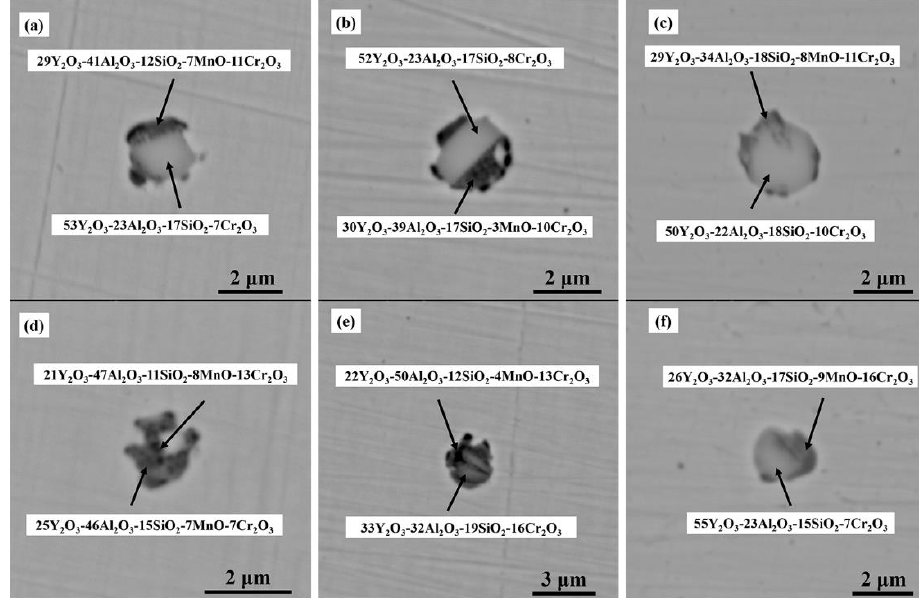
Figure 5. Morphology of typical oxide inclusions in steel #2 after isothermal heating for 0.5 h ( a ) and ( d ), 1.0 h ( b ) and ( e ), and 2.0 h ( c ) and ( f ).